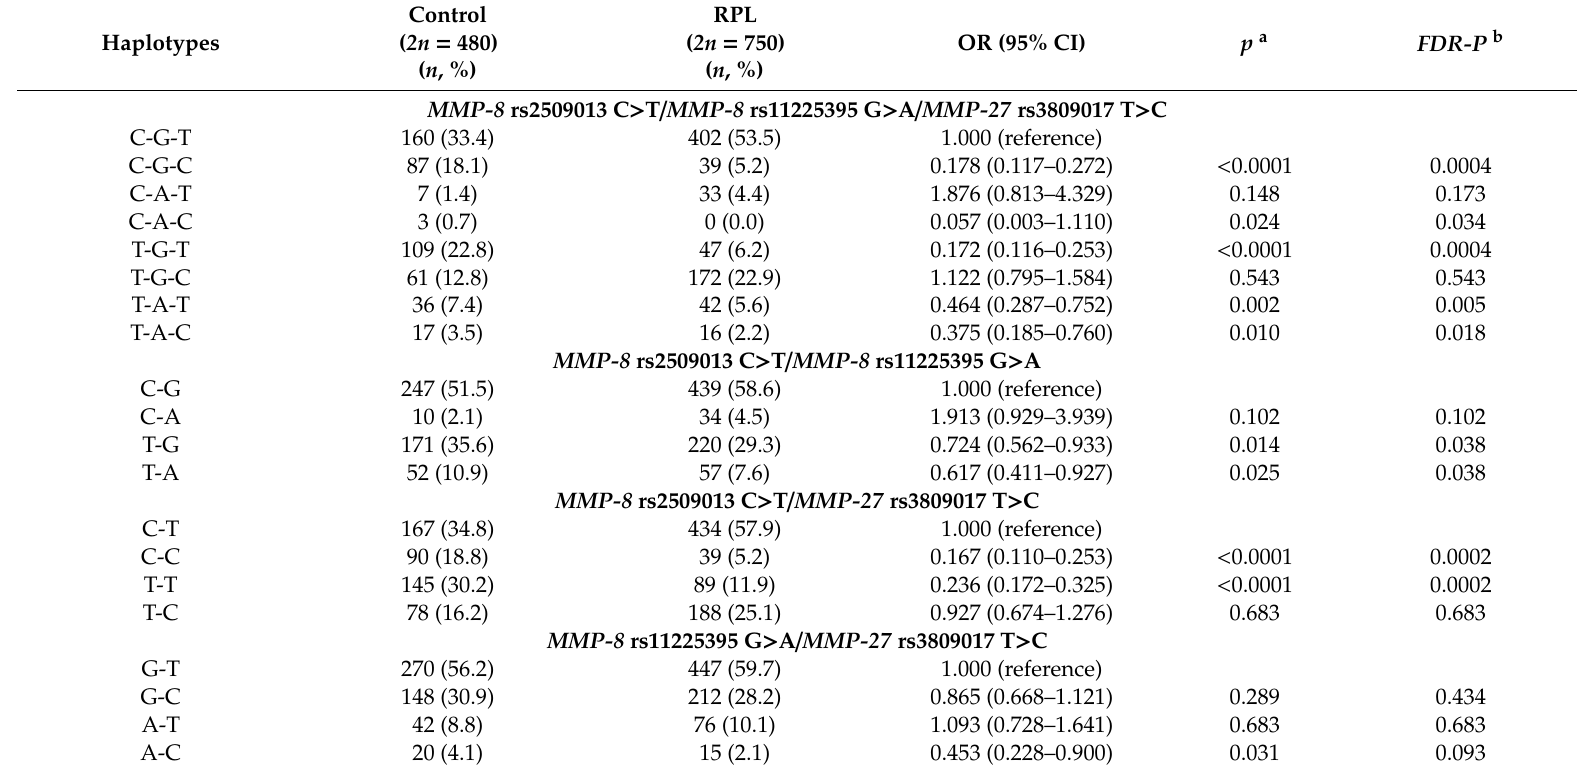
Table 3. Haplotype analysis of MMP gene polymorphisms in the RPL patients and control